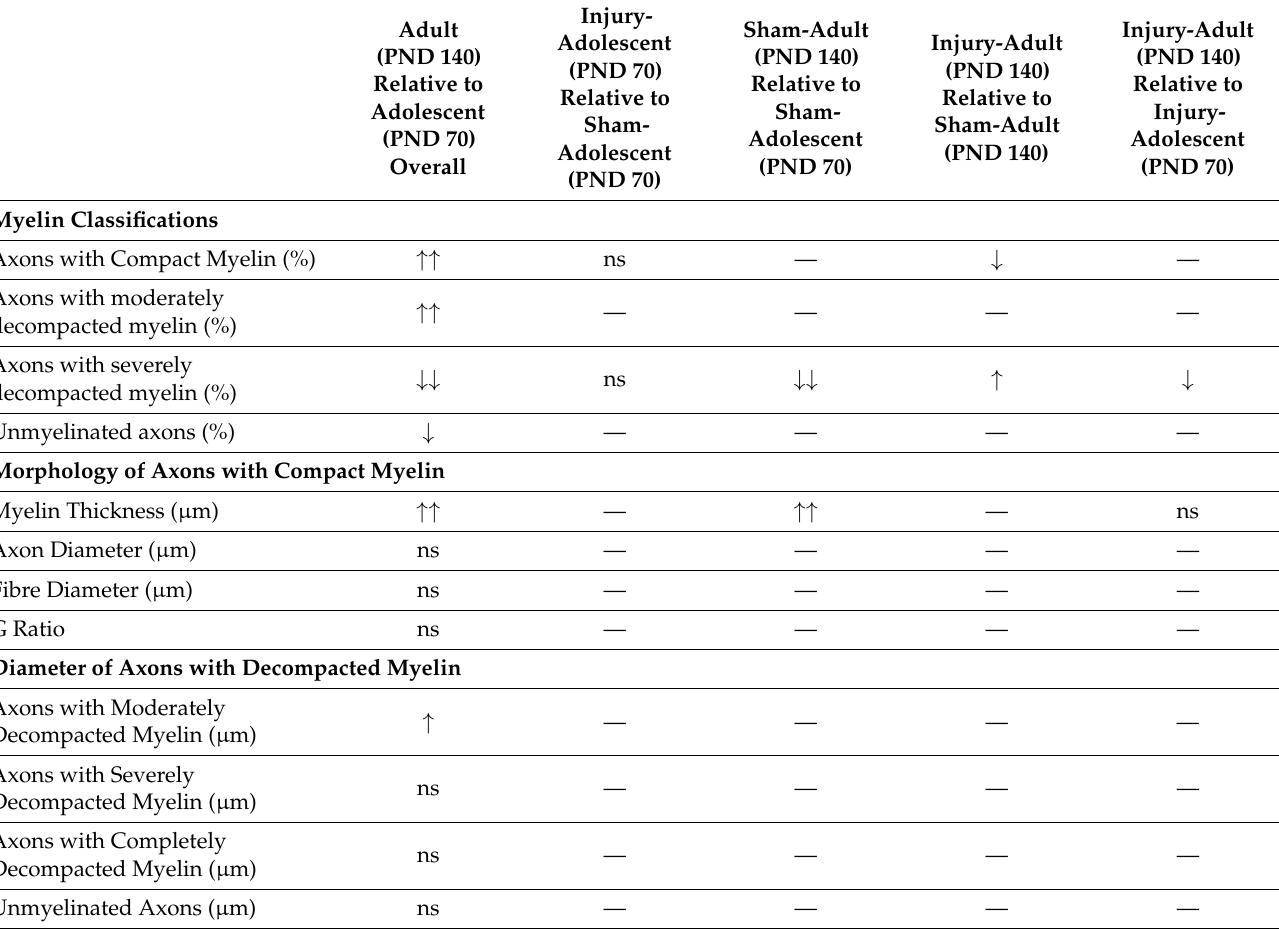
Table 1. Summary of maturation changes to myelin and axons between PND 70-140, with and without